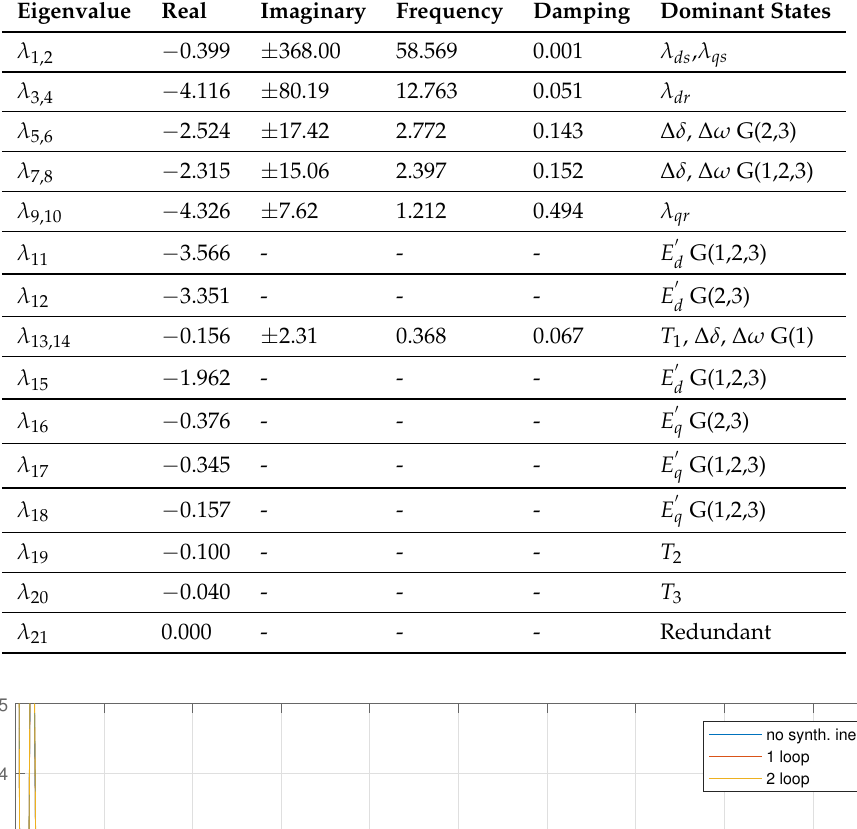
Table 1. Eigenvalues of state matrix—base case.